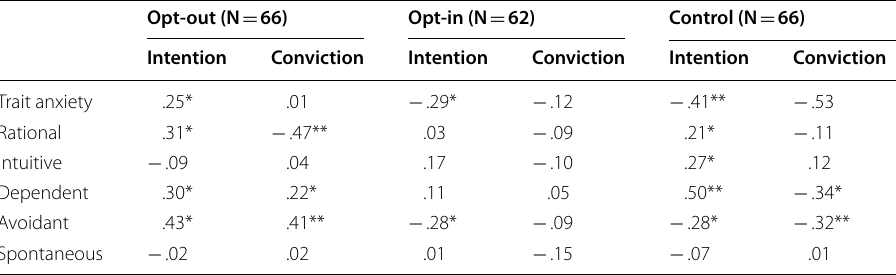
“Intention” is the intention to invest (scores from 0 to 3); “conviction” is the conviction to make the investment decision (scores from 3 to 30) * p < .05, ** p <